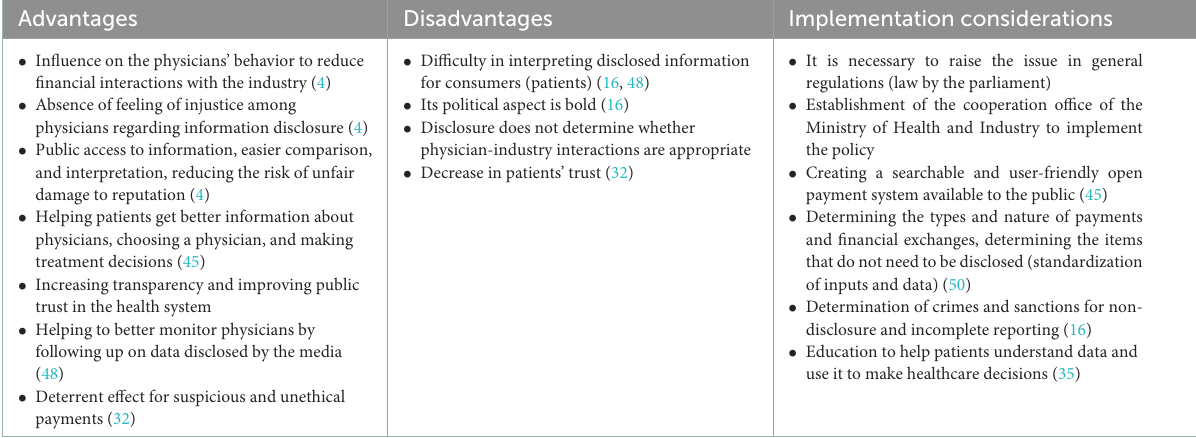
TABLE 7 Advantages, disadvantages, and implementation considerations of policy options: 5. Mandatory industry